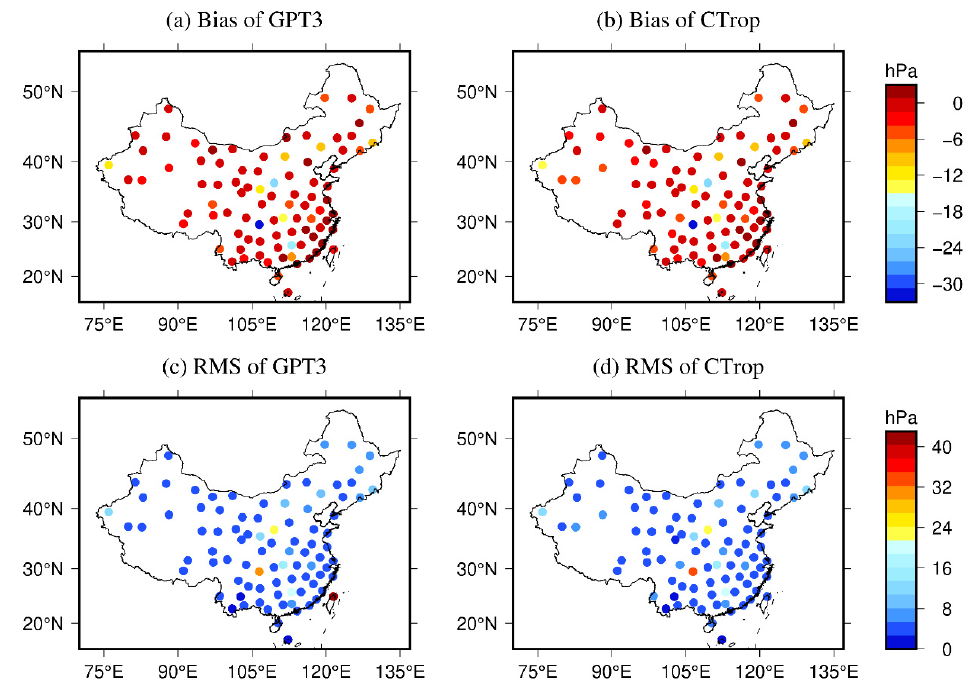
Figure 7. Distribution of the performance of pressure at each radiosonde site in 2017 by the CTrop and GPT3 models: ( a ) Bias of GPT3; ( b ) Bias of CTrop; ( c ) RMS of GPT3; ( d ) RMS of CTrop. The positive bias means the model outputs are larger than the reference values, while the negative bias means they are smaller than the reference values.